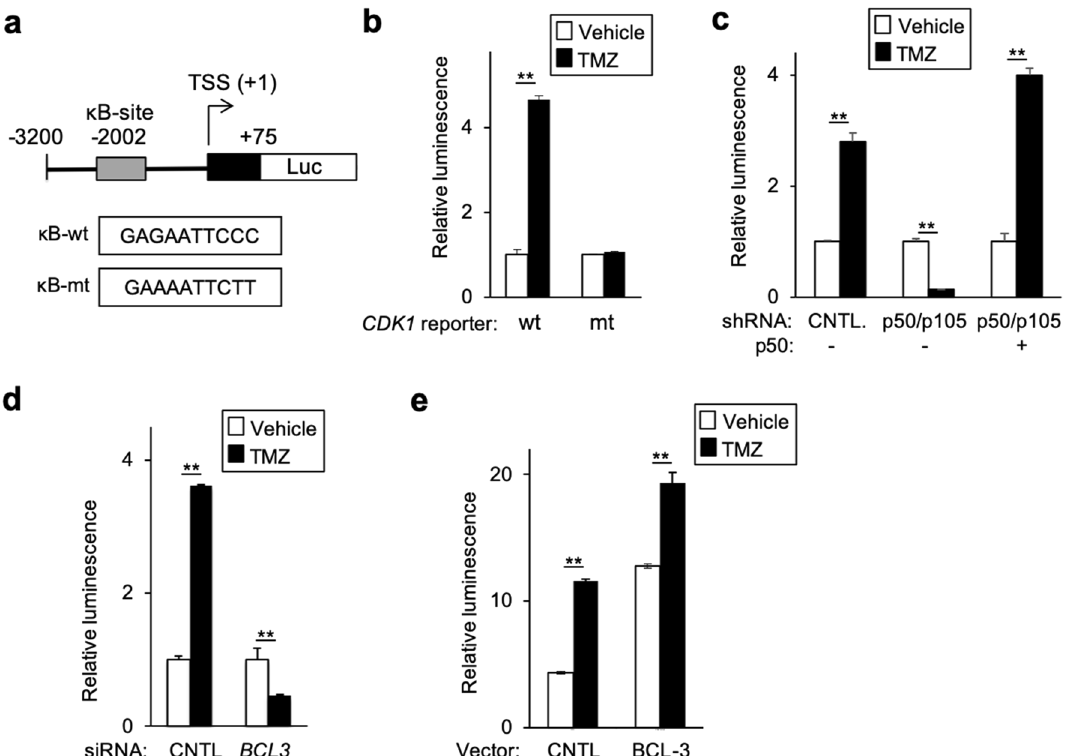
Figure 4. The κB-site is required for activation of a CDK1 promoter-reporter by TMZ. ( a ) Schematic representation of the 3.2 kbp CDK1 promoter-reporter. ( b ) Luciferase expression from the indicated reporter relative to renilla in U87 cells following treatment with vehicle or TMZ (100 μM, 24 h). ( c – e ) Luciferase assays using the wildtype reporter in U87 cells following treatment with TMZ (100 μM, 24 h). ( c ) U87 cells stably expressing sh-control (cntl) or sh-p50/p105, transfected with empty vector (EV) or p50. ( d ) U87 cells transfected with si-control or si- BCL3 . ( e ) U87 cells transfected with EV or BCL-3. Data represent relative luciferase expression normalized to control, ± SD of triplicate samples, repeated. ** P <